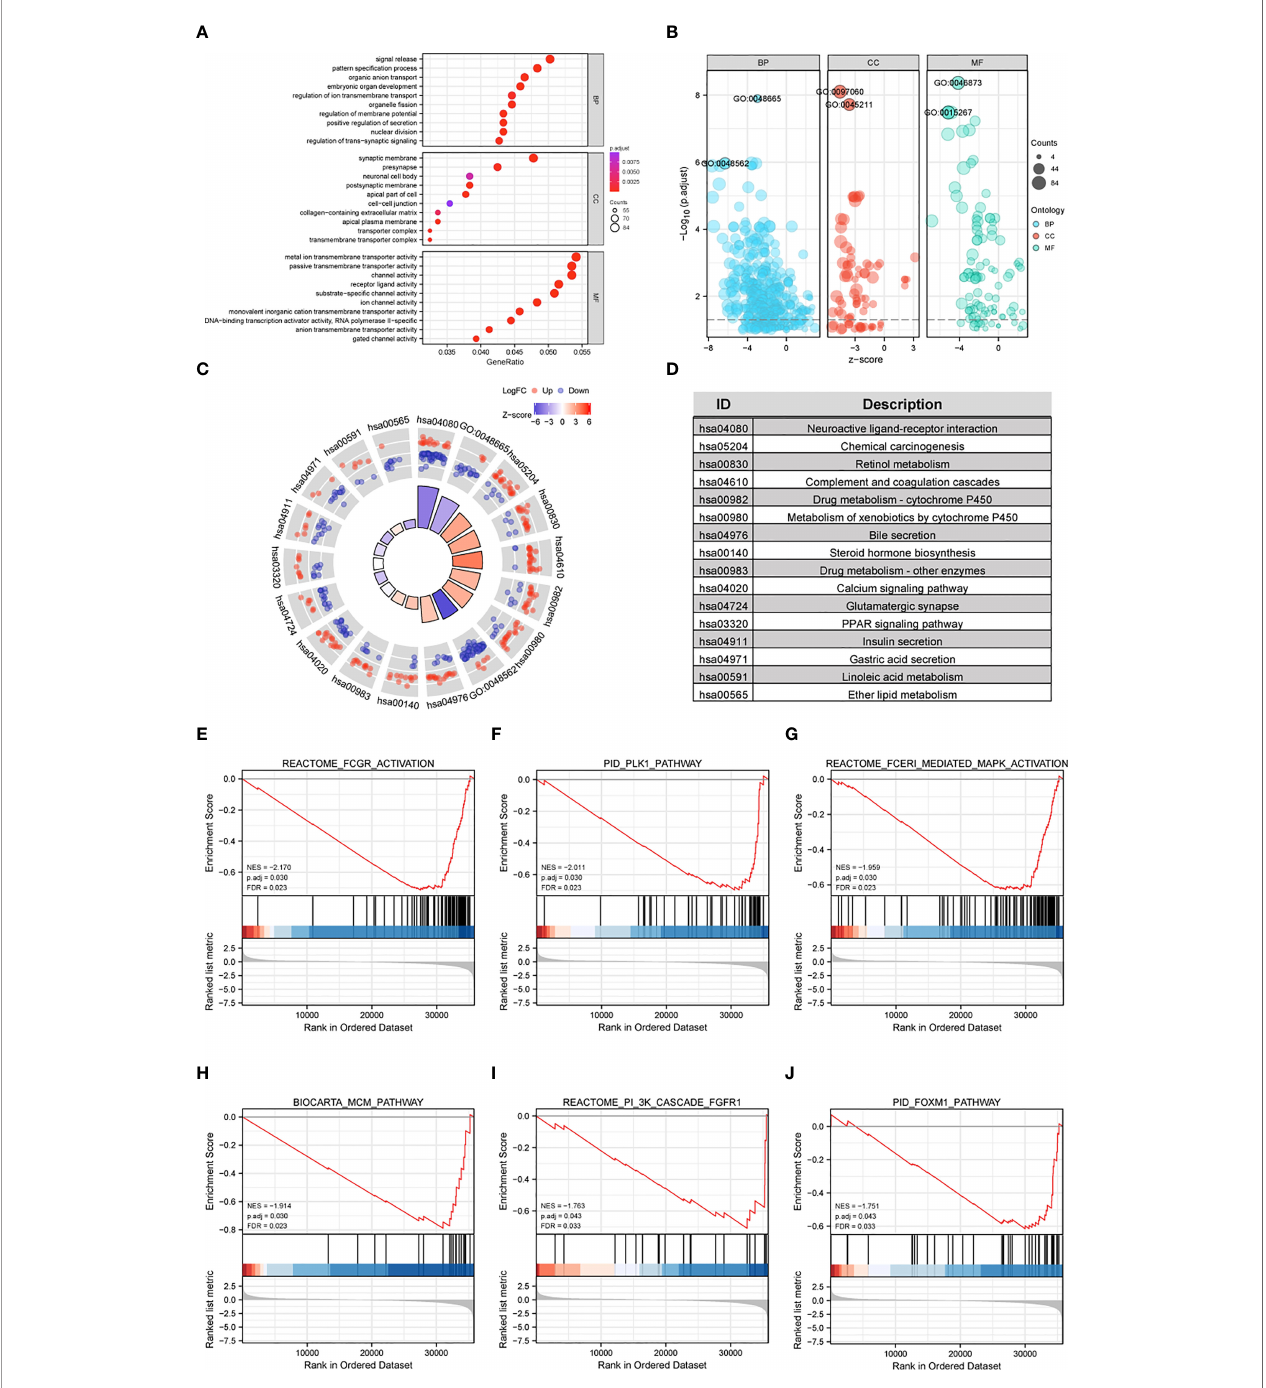
FIGURE 2 | Functional enrichment analyses of CFHR4-related genes in HCC. (A, B) The enriched terms in GO categories in HCC. (C, D) KEGG pathway analysis based on CFHR4-associated DEGs. (E – J) GSEA enrichment plots, including FCGR, activated reaction, PLK1 pathway, reactant FCERI-mediated MAPK activation, ATR pathway, MCM pathway, cascade reactions of PI3K and FGFR1, reactant-mediated MAPK activation and FOXM1